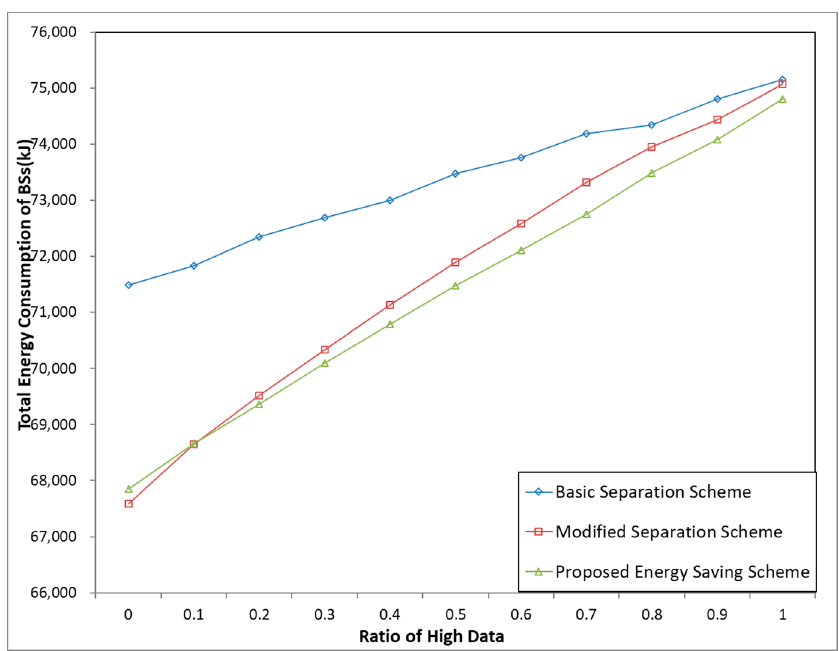
Figure 14. Energy consumption of BSs due to state switching. Energies 2017 , 10 , 1417